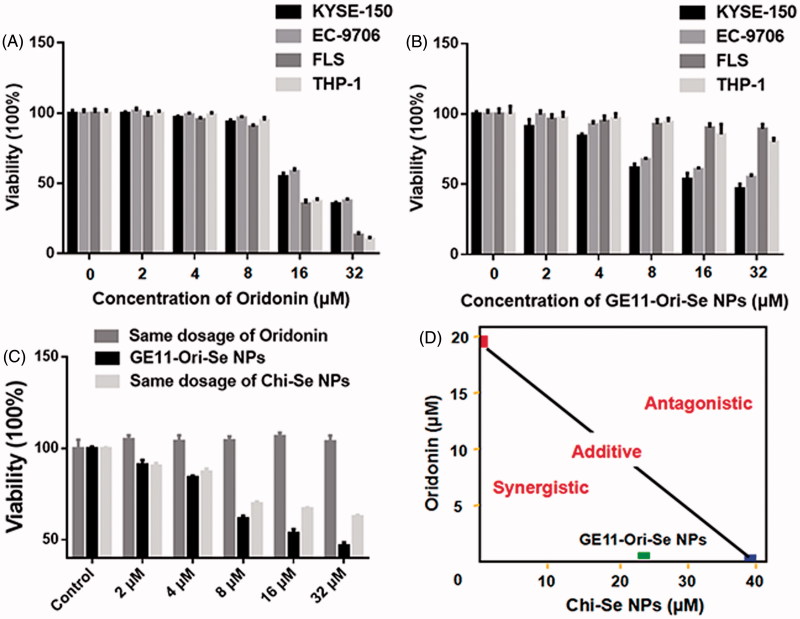
Selective inhibition effects and synergistic/antagonistic analysis of the inhibition effects of GE11-Ori-Se NPs on cancer cells. (A) Effects of oridonin on the viability of human esophageal cancer KYSE-150 cells, human esophageal cancer EC-9706 cells, human fibroblast-like synovial cells and human THP-1 cells, n = 3. (B) Effects of GE11-Ori-Se NPs on the viability of human esophageal cancer KYSE-150 cells, human esophageal cancer EC-9706 cells, human fibroblast-like synovial cells and human THP-1 cells, n = 3. (C) Effects of GE11-Ori-Se NPs, and the same dosage of oridonin or Chi-Se NPs on the viability of KYSE-150 cells, n = 4. (D) Isobologram examination of the growth inhibition effects of GE11-Ori-Se NPs, oridonin and Chi-Se NPs on KYSE-150 cells.